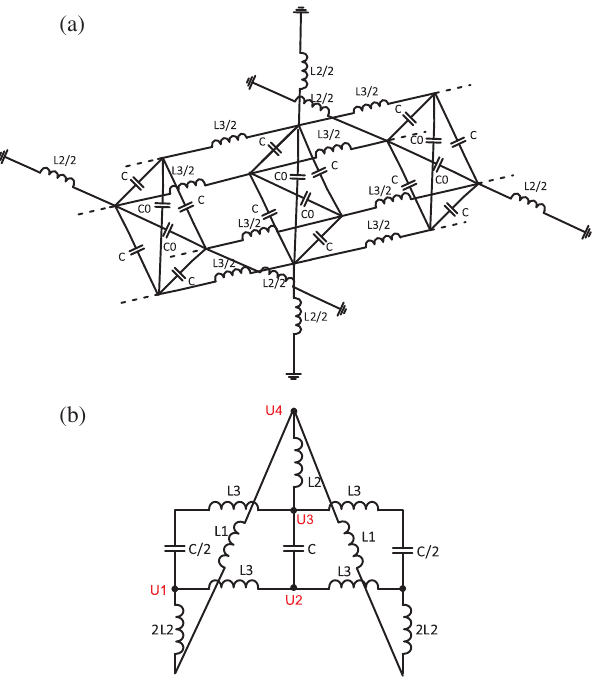
FIG. 15. Equivalent circuit of a window-type RFQ. (a) The whole circuit without equivalent inductance L 1 . (b) The sim- plified circuit per section per